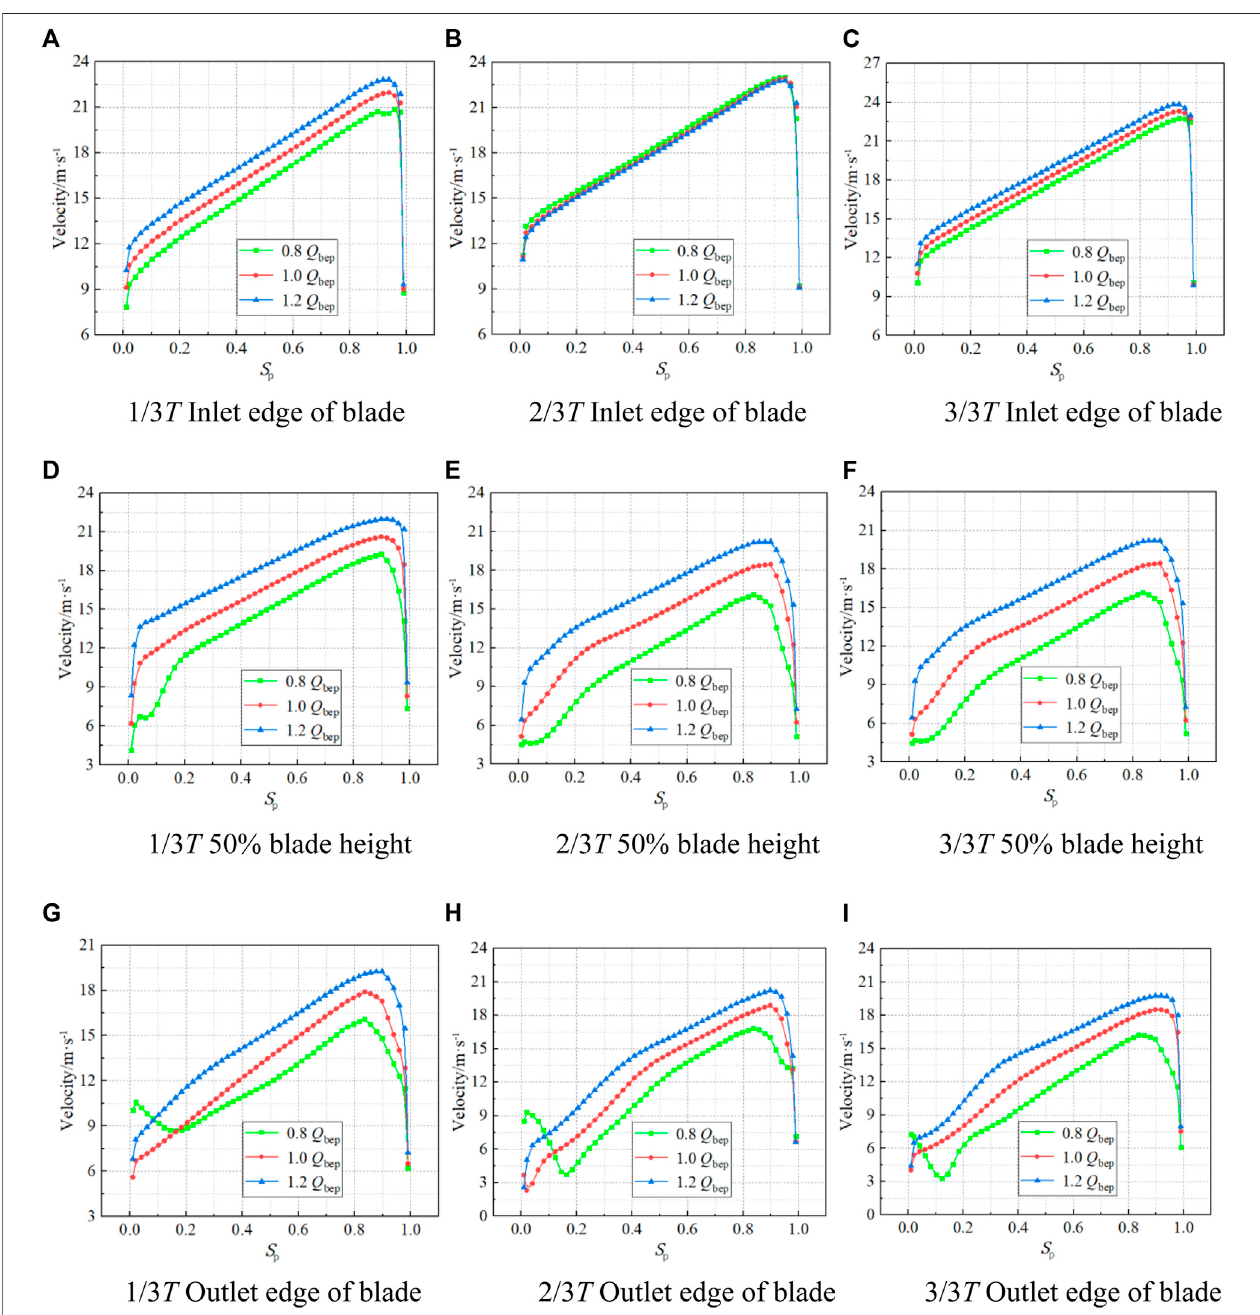
FIGURE 7 | Velocity distribution of the impeller blade inlet and outlet edge and 50% blade height under different fl ow conditions at different times.